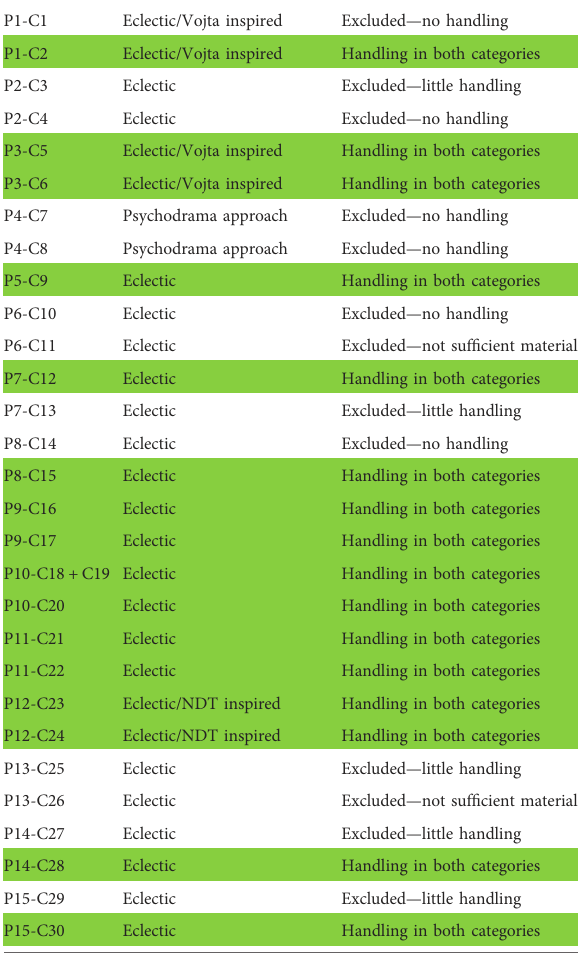
TABLE 2 Overview of participating physical therapists and the inclusion/exclusion